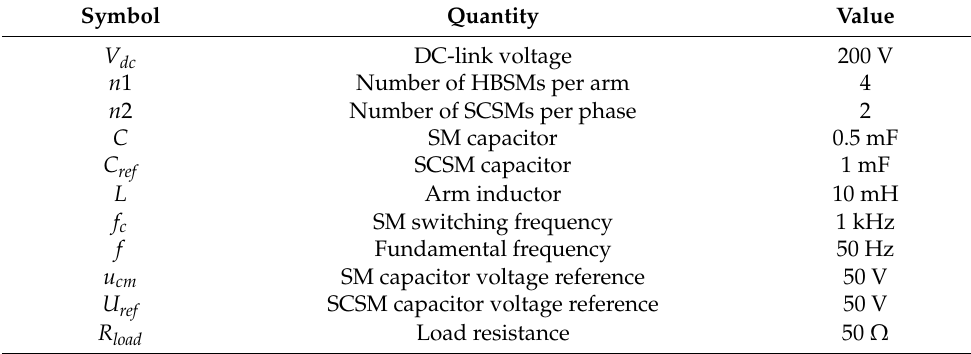
Table 3. Circuit parameters for